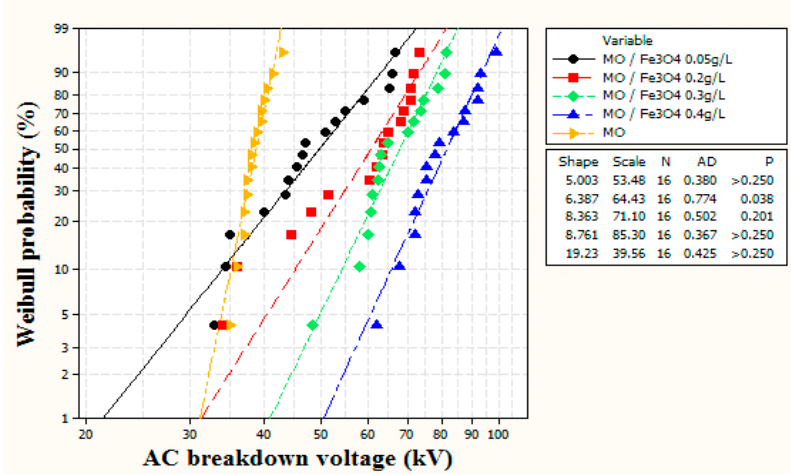
Figure 4. Weibull probability of the average reading of the breakdown voltage of MO/Fe 3 O 4 NFs.